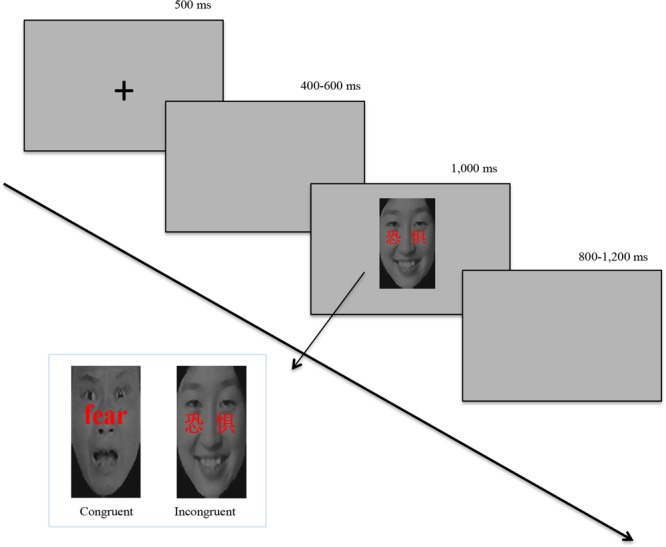
Flowchart of one experimental trial and compound stimuli samples. Each trial begins with the presentation of a fixation (“+”, 500 ms, with a blank screen ISI, randomly 400—600 ms duration), followed by the combined stimuli (3.5° wide, 5° high) appearing in the center of the screen (time limit: 1,000 ms, with a blank screen ITI, randomly 800-1,200 ms duration). When participant’s response time is shorter than programmed time limit (1,000 ms), presentation time equals participant’s response time. When participant’s response time is longer than programmed time limit (1,000 ms), presentation time is 1,000 ms.